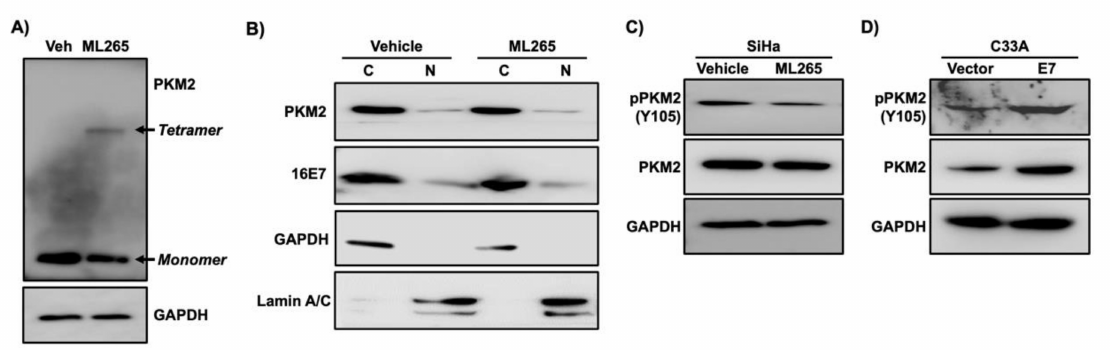
Figure 6. ML265 decreases the phosphorylation of PKM2 at the Y105 position. ( A ) SiHa cells were treated with ML265 (40 µ m) or vehicle (veh) for 24 h and then treated with paraformaldehyde for cross-linking. Total cell extracts were analyzed with western blot. GAPDH was used as a loading control. Note that ML265 decreased monomer and increased tetramer. ( B ) SiHa cells were treated with vehicle and ML265 for 24 h. Cells were nearly confluent at the endpoint. The cytoplasmic fraction (C) and the nuclear fraction (N) were analyzed with western blot. GAPDH and lamin A/C were used as a cytoplasmic and nuclear fraction marker, respectively. ( C ) SiHa cells were treated with ML265 for 24 h. Total cell extracts were subject to western blot analysis. ( D ) Total cell extracts from C33A-vector and C33A-E7 cells described in Figure 3A were analyzed with western blot. Note that both pY105-PKM2 and total PKM2 were increased in C33A-E7 cells compared to the control